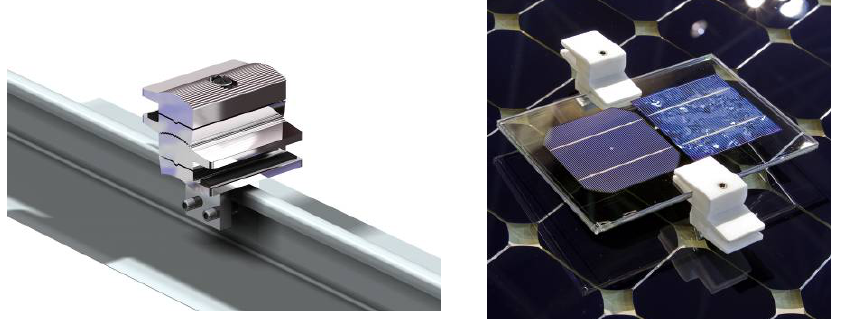
Figure 6: Design of solar clamp, Figure 7: Prototype of solar clamp.